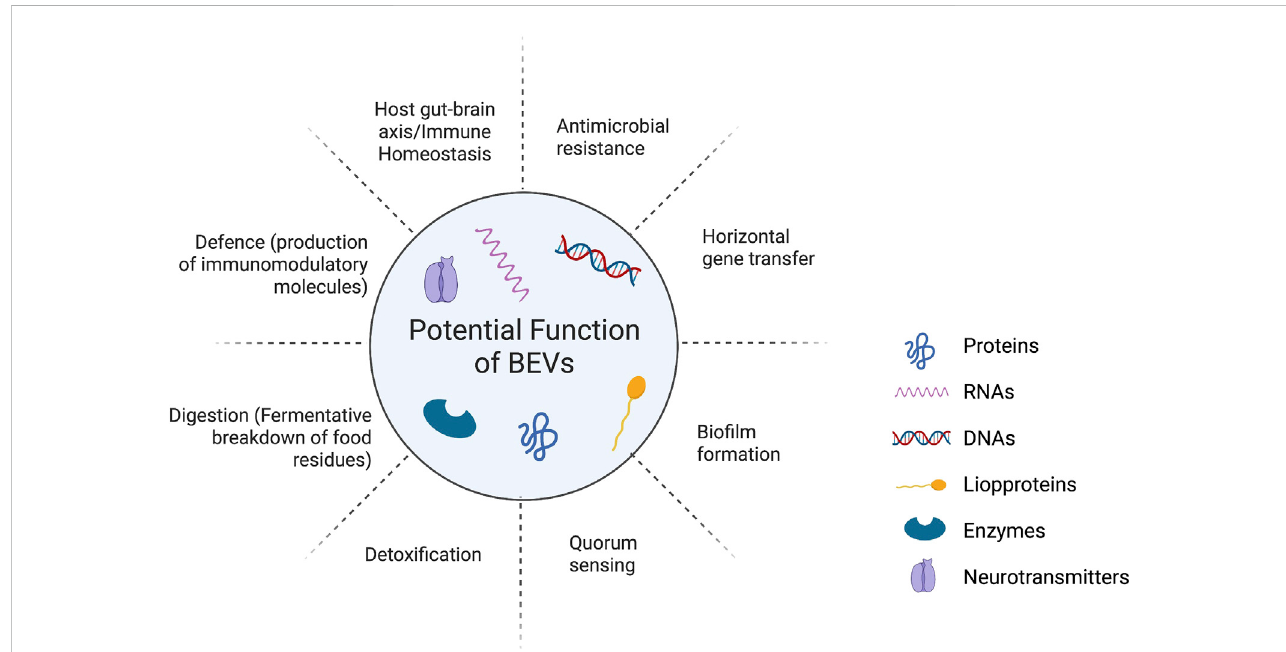
FIGURE 1 The roles of bacterial extracellular vesicles (BEVs) on the health of the host as a vehicle for moving bioactive payload (such as miRNA, DNA, mRNA, proteins, lipids, and carbohydrates) and their potential